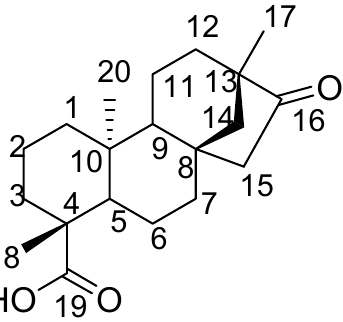
Figure 1. The chemical structure and atom number of isosteviol.